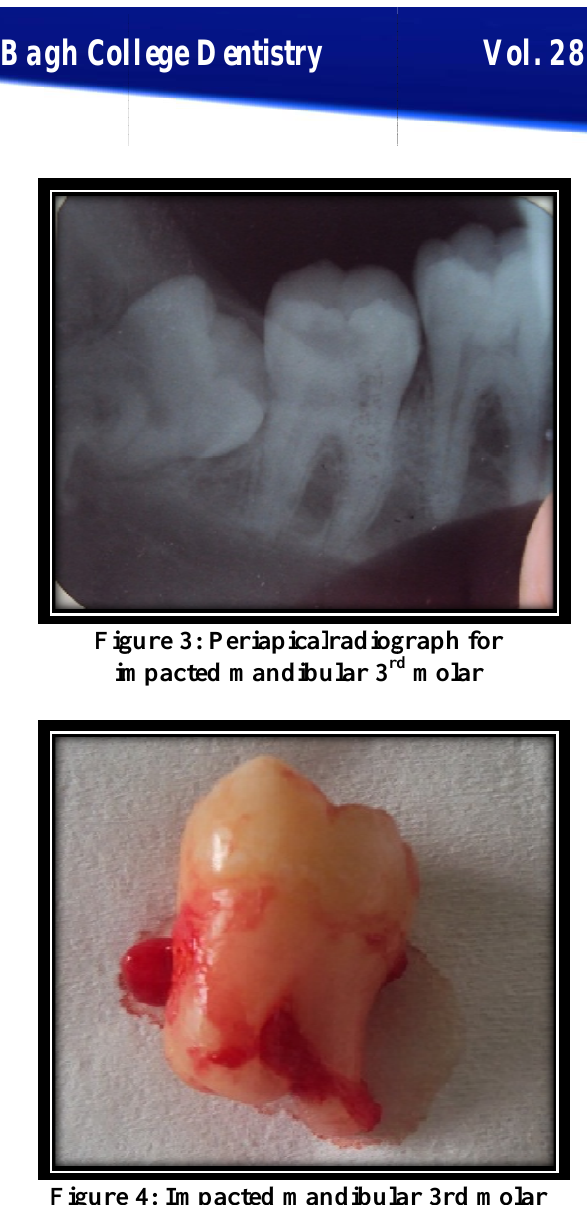
Figure 4: Impacted mandibular 3rd molar removed from the socket In case of exposure of impacted c In case of exposure of impacted c envelope flap was usedthrough palatal approach